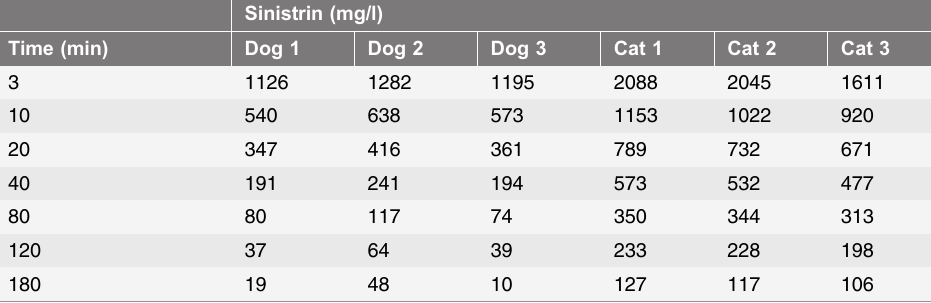
Table 1. Plasma inulin data in all animals studied.